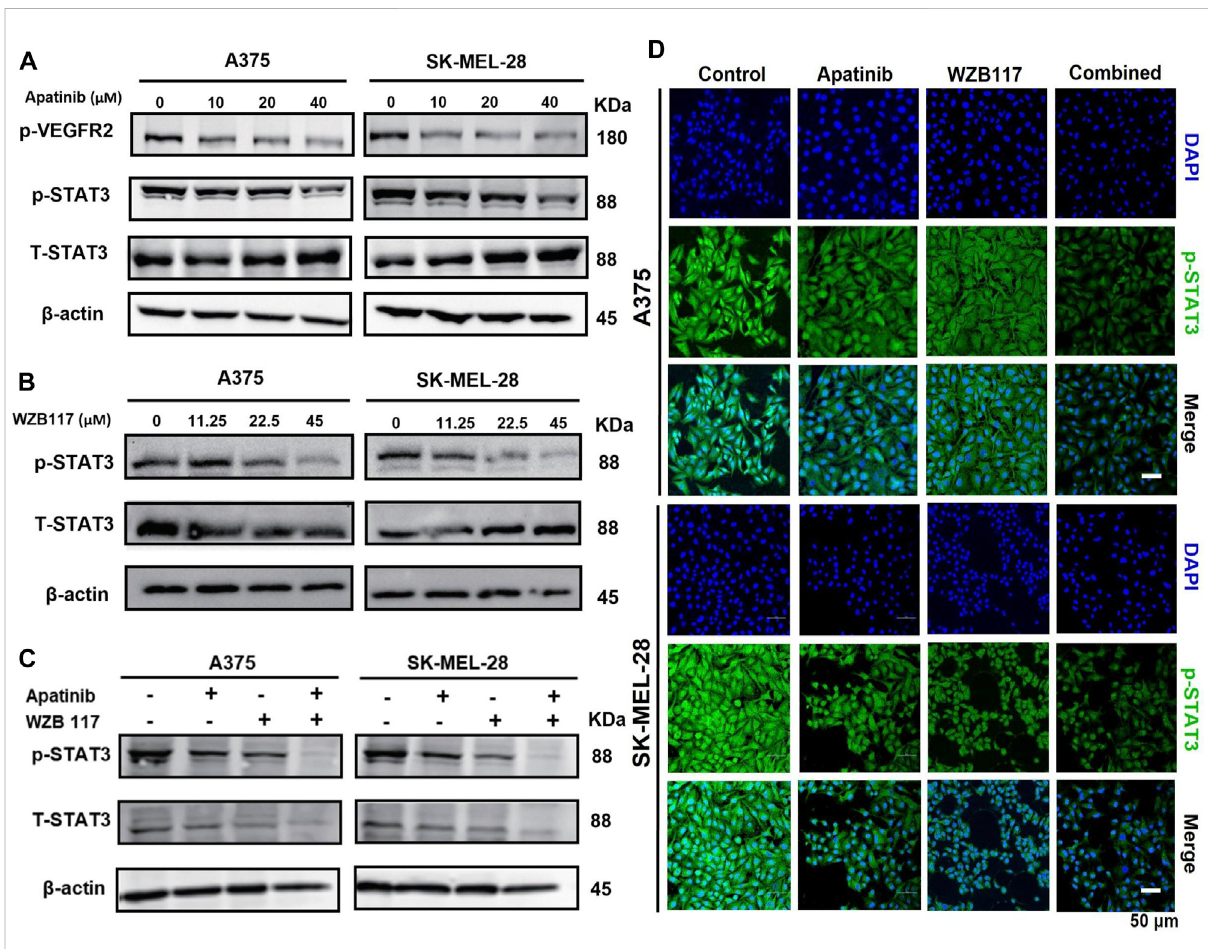
FIGURE 3 EffectofapatinibcombinedwithWZB117ontheSTAT3pathwayinA375andSK-MEL-28cells. (A) Westernblotanalysisofproteinexpressionsof p-VEGFR2, STAT3, and p-STAT3. Both cells were treated with a range concentration of apatinib for 48 h. (B) Western blot analysis of protein expressions of STAT3 and p-STAT3. Both cells were treated with a range concentration of WZB117 for 48 h. (C) Western blot analysis of protein expressions of STAT3 and p-STAT3. (D) Immuno fl uorescence staining of p-STAT3. Both cells were treated with apatinib and WZB117, either alone or in combination, for 48 h (p-STAT3: green; DAPI: blue). Scar bar = 50 μ